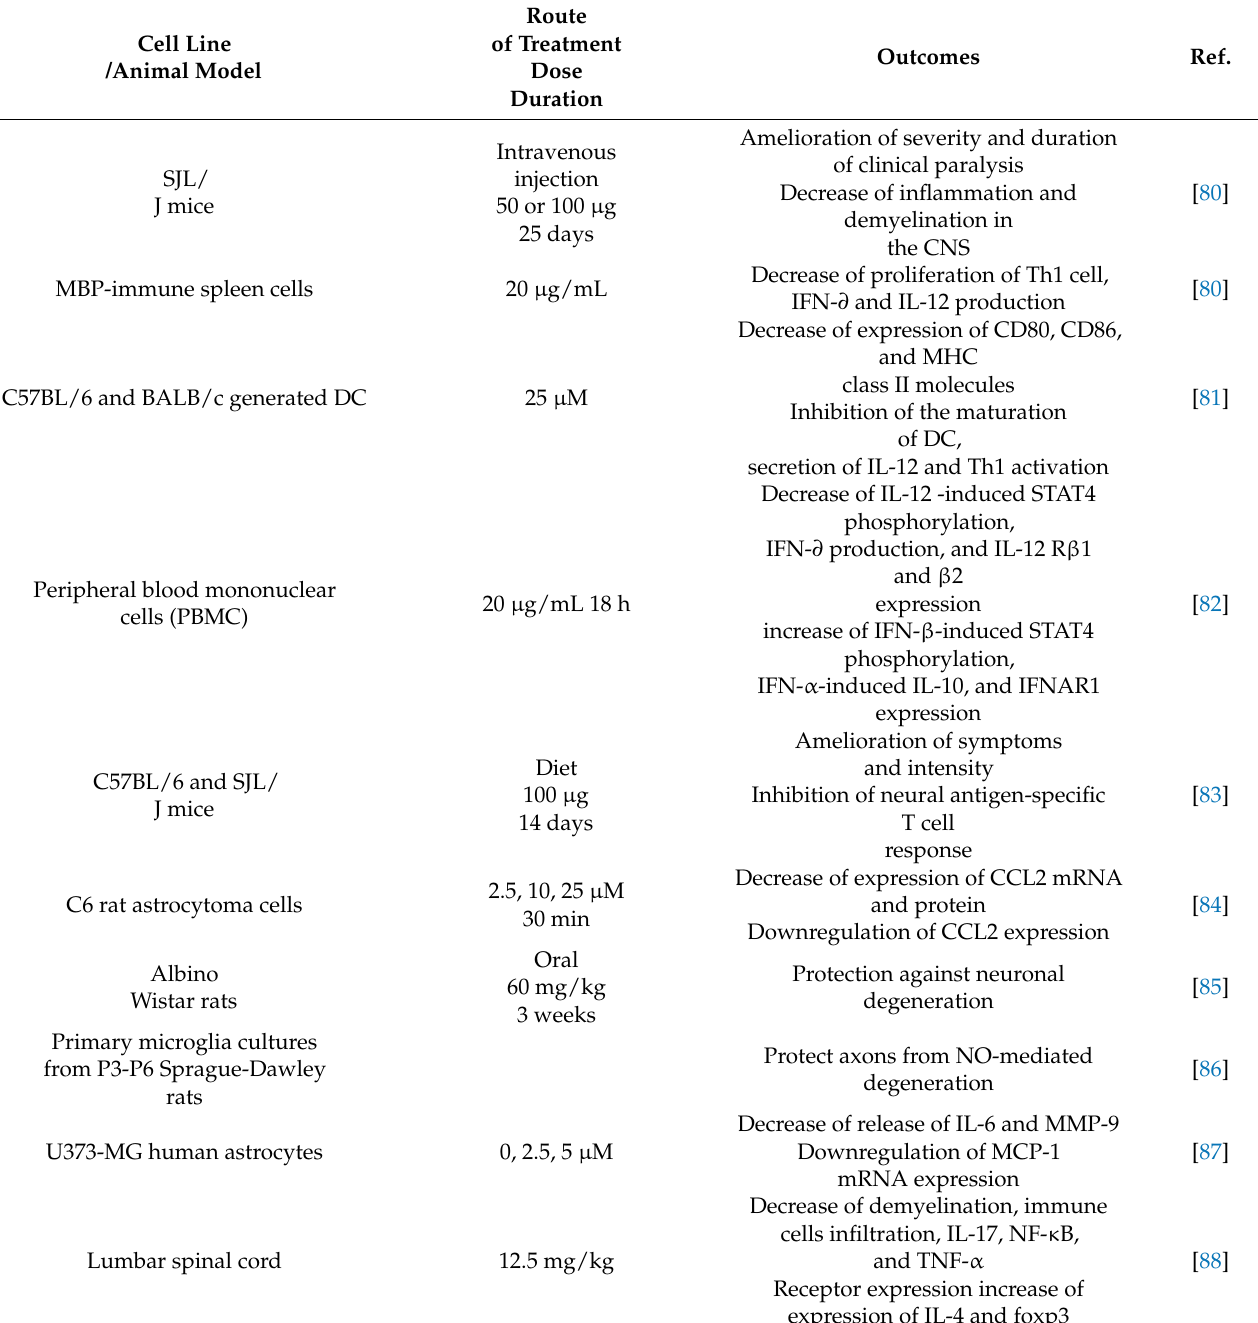
Table 3. In vitro and in vivo studies of curcumin on multiple